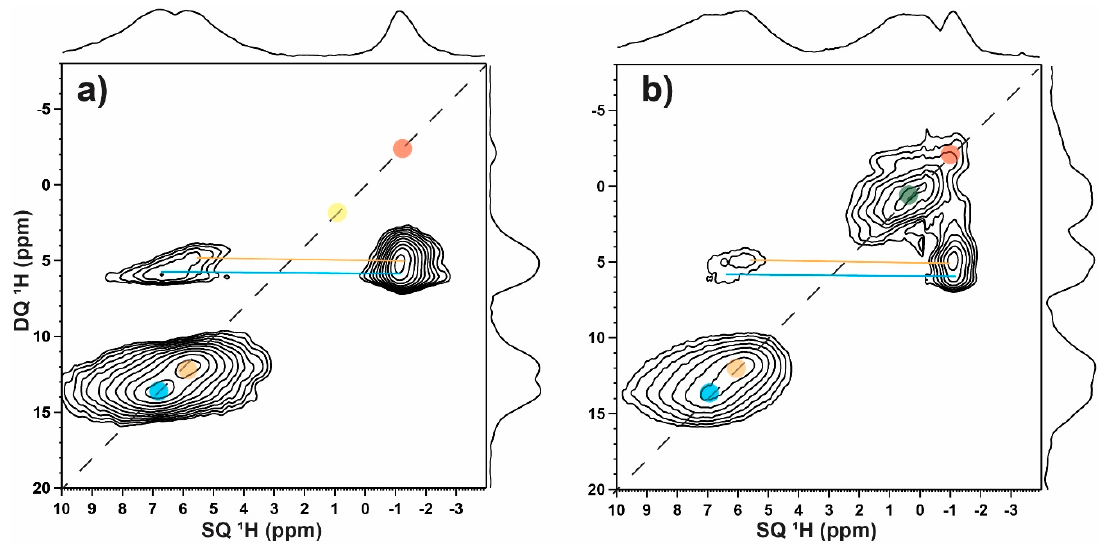
Figure 2. 2D double quantum (DQ)-single quantum (SQ) 1 H-MAS-NMR correlation spectra for ( a ) hydromagnesite, 4MgCO 3 ·Mg(OH) 2 ·4H 2 O and ( b ) artinite, MgCO 3 ·Mg(OH) 2 ·3H 2 O. The auto-correlation peaks between protons in the same environment (chemical shift) are identified by solid circles, and the colored lines identify correlation between different proton environments.